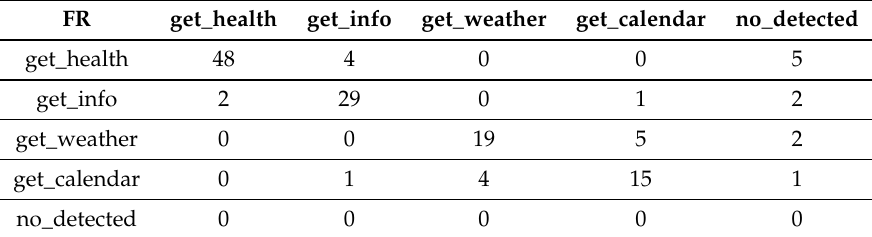
Table 6. Confusion matrix for the intent detection for the French language.